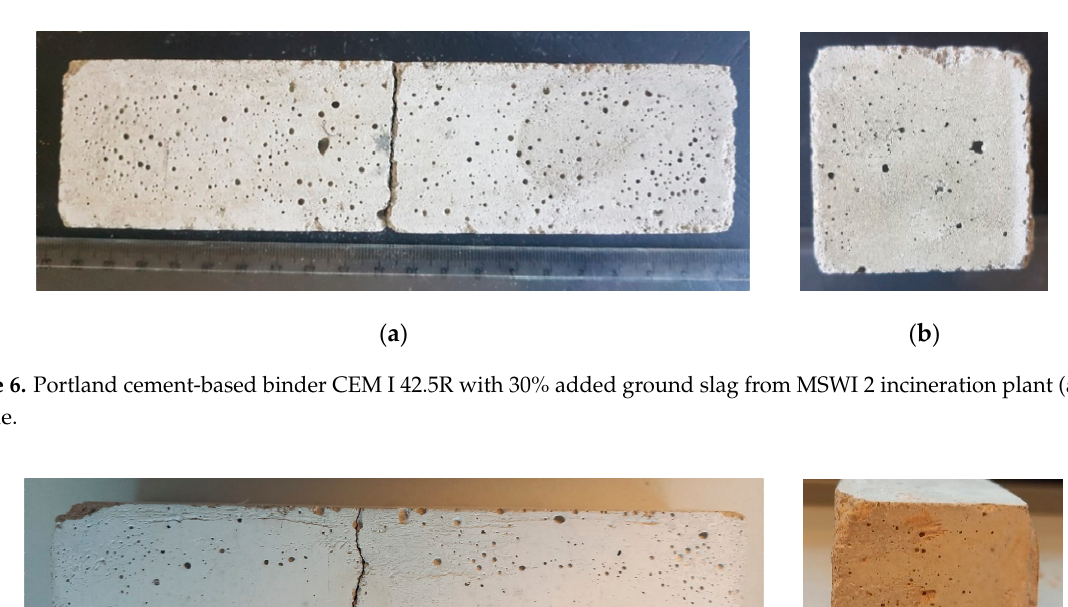
Figure 5. Portland cement-based binder CEM I 42.5R with 30% added ground slag from MSWI 1 incineration plant ( a ) front, ( b ) side.